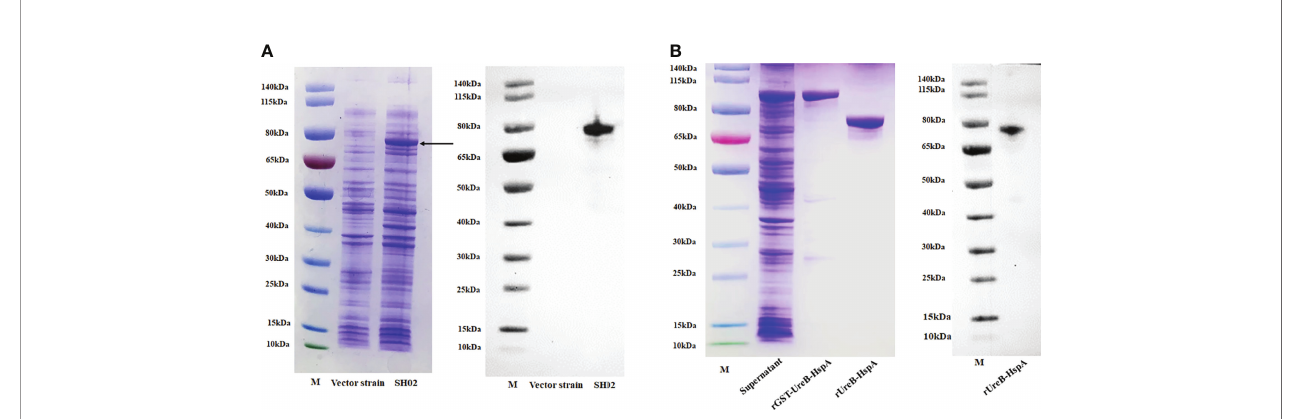
FIGURE 1 | Expression, puri fi cation, and validation of proteins. (A) UreB-HspA was expressed in SH02 strain (left) and validated with UreB monoclonal antibody (right). The bond of UreB-HspA was marked by black arrow. Vector strain served as negative control. M: Marker; Lane 1: Vector strain; Lane 2: Candidate vaccine strain SH02. (B) Expression and puri fi cation of rGST-UreB-HspA (left), veri fi ed with UreB monoclonal antibody (right) after GST tag removal. M: Marker; Lane 1: Supernatant of ultrasonic broken material of E . coli BL21 (pGEX-6P-UreB-HspA); Lane 2: rGST-UreB-HspA; Lane 3: